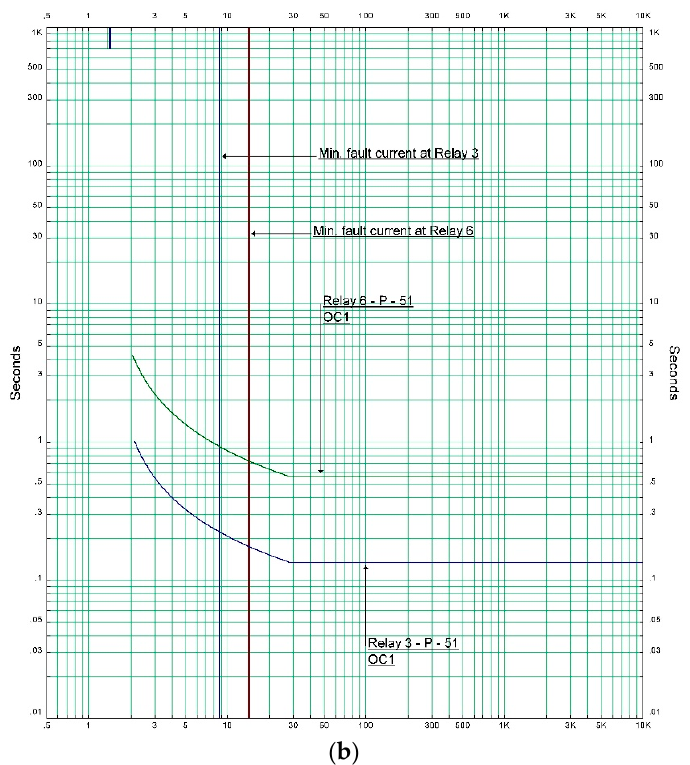
Figure 9. Time-current curves of relays 3 and 6 in case study 1 when applying: ( a ) The proposed algorithm, ( b ) The PSO algorithm.